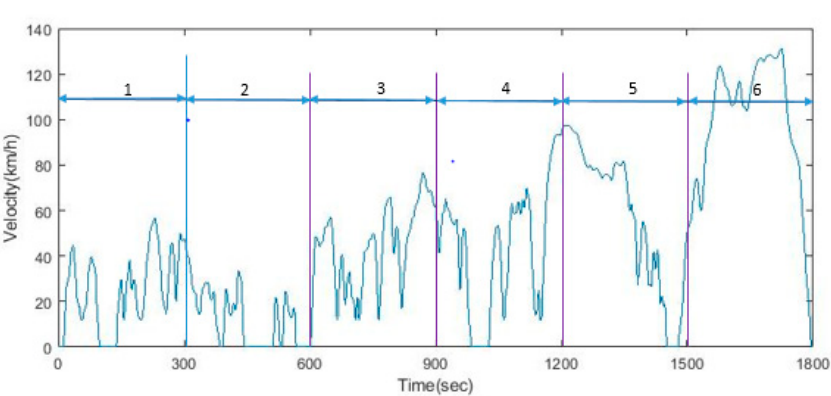
Figure 3. Schematic diagram of micro-trips.